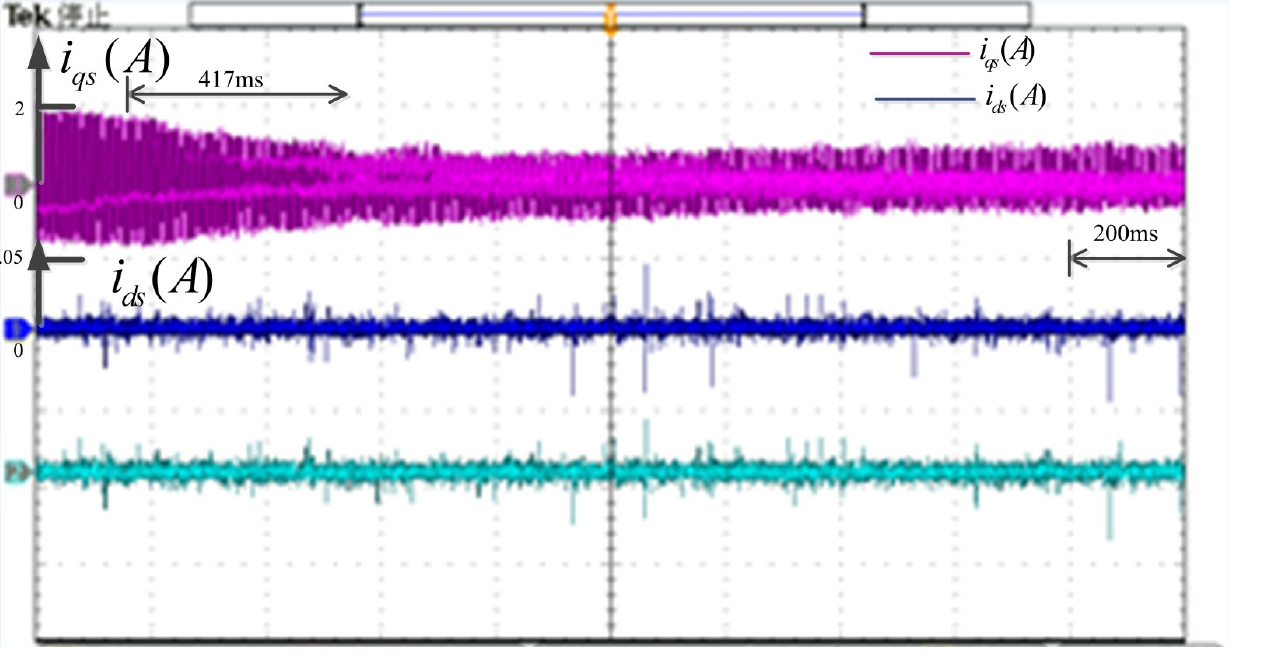
Figure 6. The validation results of the traditional PI + PID control for the abrupt load torque change of system parameters under inductance parameters L d = 1.2ˆ L d , L q = 0.8ˆ L q . The top plot displays the q -axis stator current ( i qs ), and the bottom plot displays the d -axis stator current ( i ds